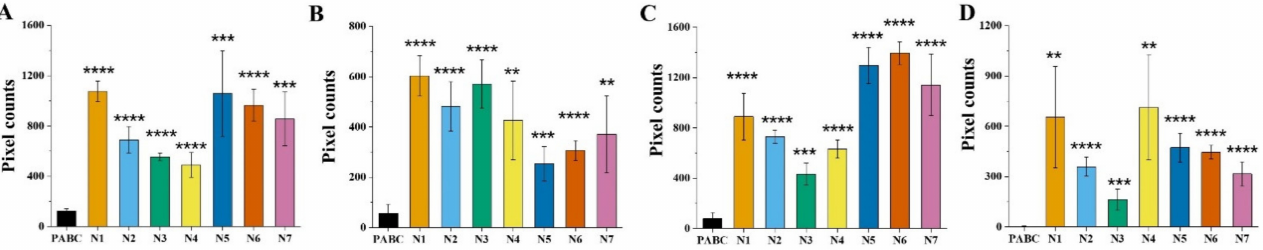
Figure 3. The average NAD(P)H t m and a 2 distribution curve peak heights of PABC and the normal group (including seven pairs of normal maternal blood and umbilical cord blood, N1-N7). ( A ) NAD(P)H- t m peak 2 height in maternal blood, ( B ) NAD(P)H- a 2 peak 3 height in maternal blood, ( C ) NAD(P)H- t m peak 2 height in cord blood, and ( D ) NAD(P)H- a 2 peak 3 height in cord blood (** p <0.01, *** p <0.001, **** p